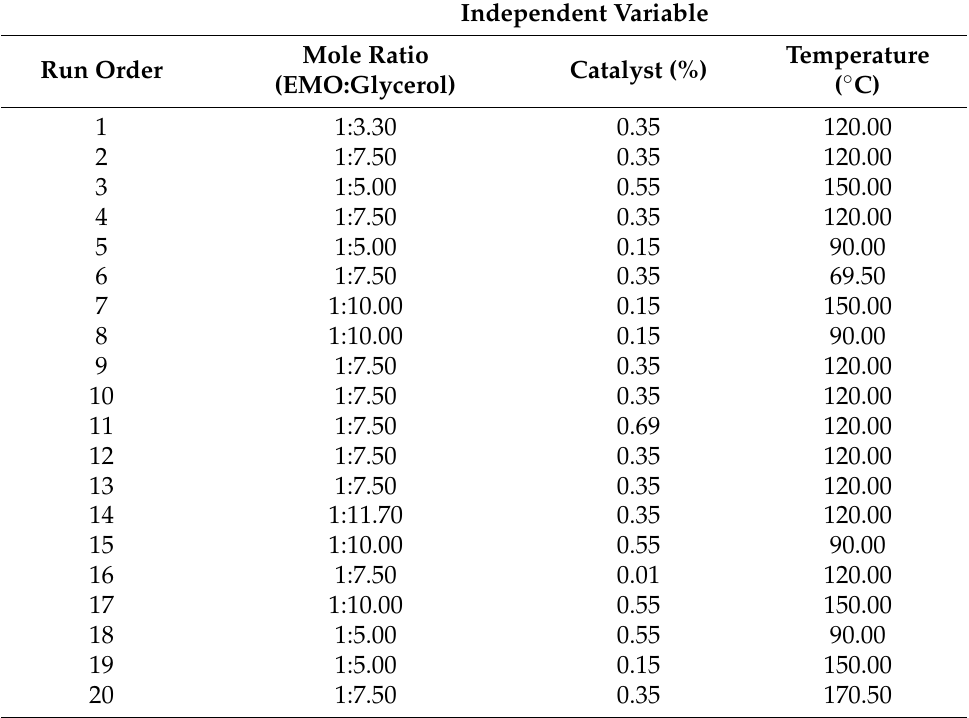
Table 9. CCRD design matrix with 20